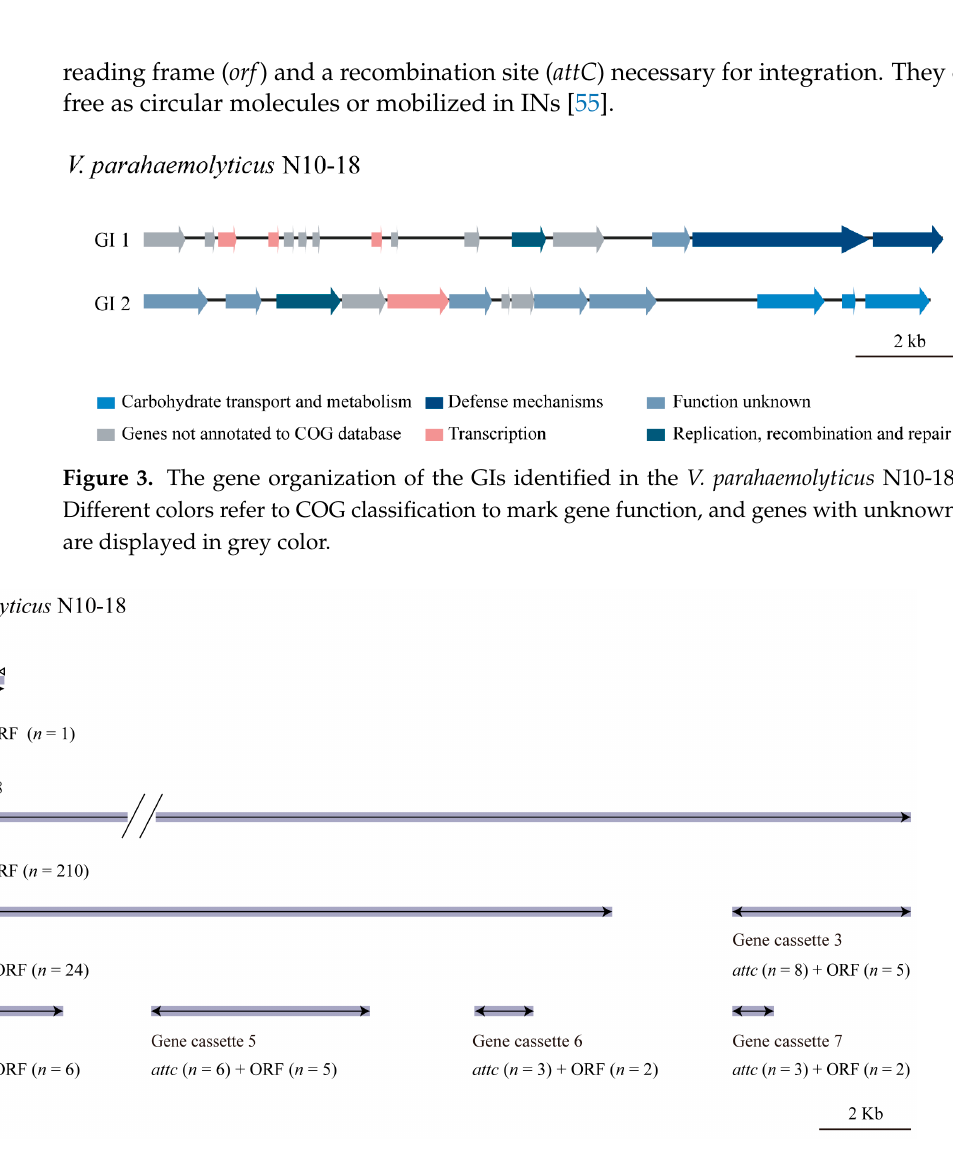
Figure 4. The structure diagram of the INs identified in the V. parahaemolyticus N10-18 genome. The complete IN and incomplete gene cassettes are shown with the predicted attc/attl sites and ORFs.